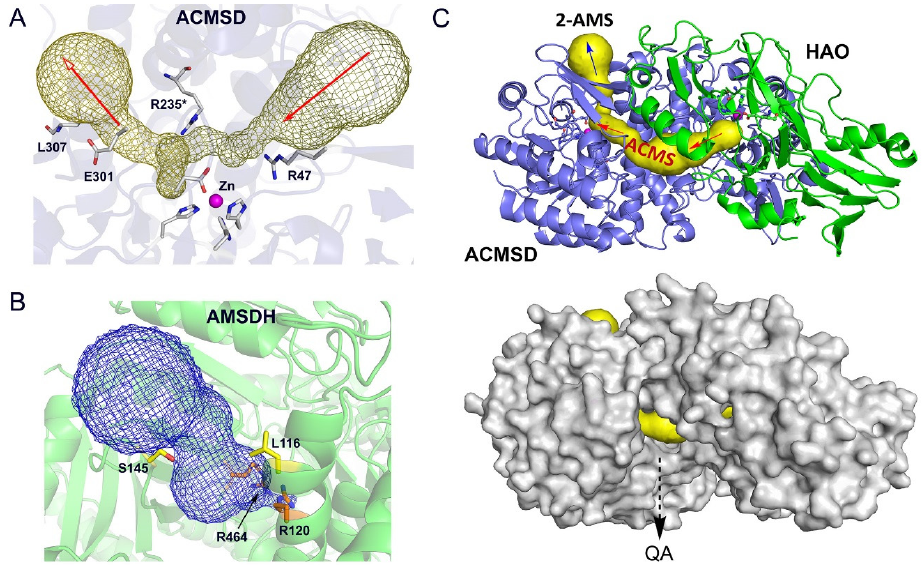
Figure 6. In silico docking model of HAO-ACMSD. ( A ) ACMSD has two tunnels that intersect at the metal center. ( B ) Pf AMSDH substrate binding channel (PDB: 4I25). ( C ) An HAO (green) and ACMSD (blue) docking model built from their corresponding crystal structures. The substrate tunnel is highlighted in yellow. A space-filling of the docking model reveals a leak point that allows spontaneously formed QA to exit.